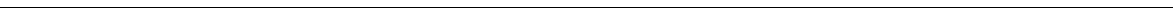
Fig. 4 Design principles and basic validations of new GCaMP-X sensors. a Design principles of GCaMP-X. CaM binding motif (CBM) was fused onto N- terminus of GCaMP to tightly bind apoCaM at rest but with relatively low af fi nity (e.g., much lower than the M13 motif) to Ca 2 + /CaM, as the central strategy for GCaMP-X design. Also, additional tags of NES (nuclear export signal), NLS (nuclear localization signal) and MTS (membrane targeting signal) motifs could be appended onto C-terminus (or N-terminus), to control speci fi c subcellular localization of GCaMP. Accordingly, a series of GCaMP-X sensors were developed, in addition to GCaMP-X O without any tag, including GCaMP-X C , GCaMP-X N, and GCaMP-X M , tagged with NES, NLS, and MTS respectively. b , c Design validation with GCaMP3 and recombinant Ca V 1.3 channels. Neither CDI nor VGA of α 1DL channels ( b ) and α 1DS channels ( c ) were altered by GCaMP3-X O or GCaMP3-X C overexpressed in HEK293 cells, as demonstrated by I Ca exemplars (top) and voltage-dependent CDI (middle) and VGA (bottom) pro fi les. d Validation of GCaMP6m-X C with neuronal Ca V 1.3 channels. Effects of GCaMP6-X C on α 1DL gating were examined in cortical neurons infected with AAV- Syn -GCaMP6m-X C , indexed with S Ca and J Ca . Dotted lines represent GCaMP6f pro fi les (Fig. 2b). e , f GCaMP-X eliminated perturbations on subthreshold Ca 2 + dynamics. For cortical neurons infected with AAV- Syn -GCaMP6m or AAV- Syn -GCaMP6m-X C , confocal fl uorescent images depict Ca 2 + dynamics in response to extracellular stimuli of 20 mM [K + ] o , indexed by normalized fl uorescence changes ( Δ F/F 0 ). Exemplar images (left), averaged curves of Δ F/F 0 (middle) and statistical summary (right) are shown for GCaMP6m and GCaMP6m-X C . Particularly, peak Δ F/F 0 and total calcium in fl ux (rightmost, area integral within 300 s, in the units of Δ F/F 0 · s) were evaluated and compared ( e ). To con fi rm, similar experiments and analyses were performed with Fura-2 ratiometric Ca 2 + imaging, indexed with fl uorescence emission ratio F 340 /F 380 achieved from 340 nm and 380 nm excitation ( f ). Standard error of the mean (S.E.M.) and Student ’ s t -test (two-tailed unpaired with criteria of signi fi cance: * p < 0.05; ** p < 0.01, and *** p < 0.001) were calculated when applicable, and n.s. denotes “ not signi fi cant